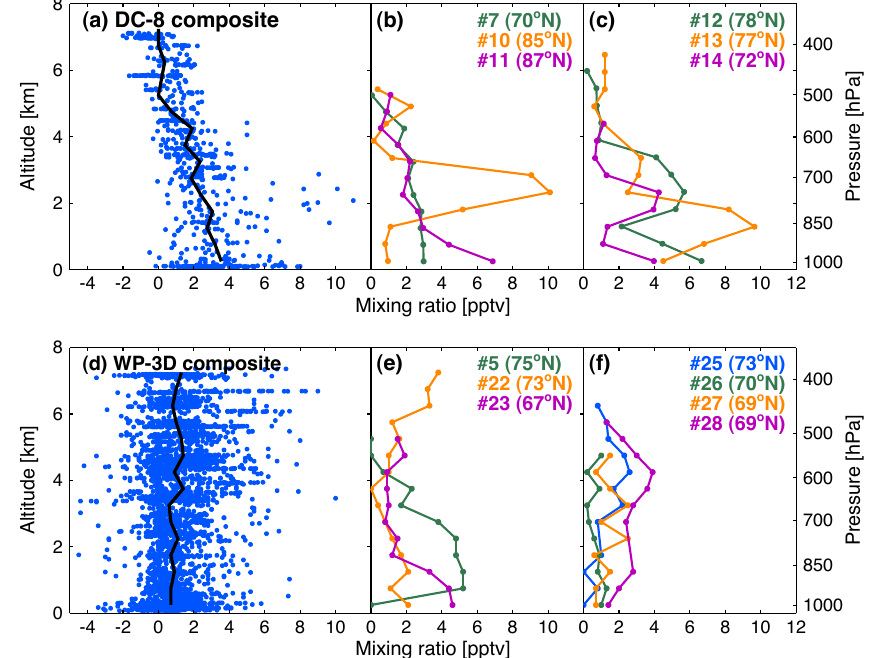
Fig. 2. (a) Collection of DC-8 measurements of BrO (blue dots) and DC-8 composite BrO profile (black line) and (b) DC-8 BrO profiles #7, #10, and #11, (c) DC-8 BrO profiles #12, #13, and #14, (d) similar to (a) but for WP-3D measurements of BrO, (e) WP-3D BrO profiles #5, #22, and #23, (f) WP-3D BrO profiles #25, #26, #27, and #28.